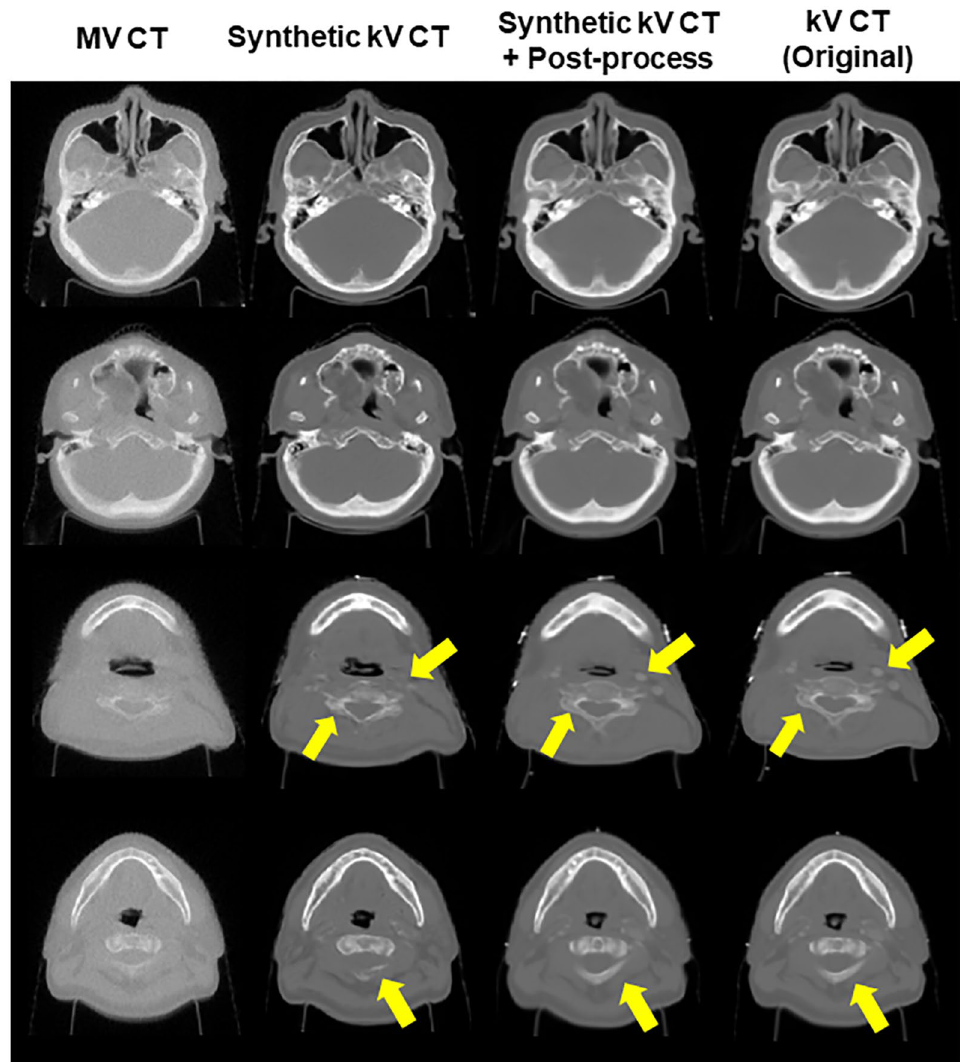
Figure 4. The results of Network1 (Synthetic kV CT) from MV CT and the images through additional processing (Synthetic kV CT + Additional Process) for 2D slices without containing metal elements, compared against true kV CT (MV CT [−1000 HU, 750 HU], kV CT: [−1000 HU, 1500